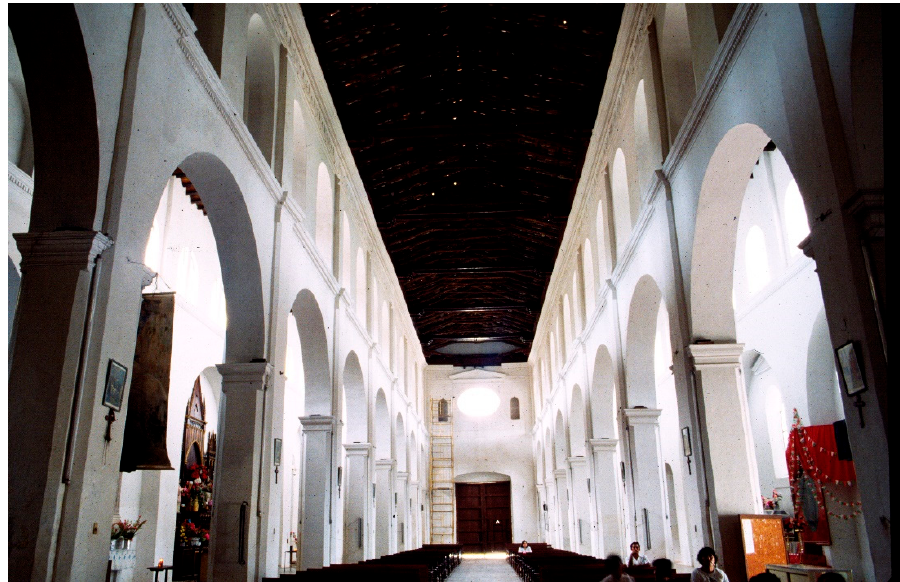
Figure 5. Interior of Santo Domingo church. Chiapa del Corzo. Photo took by author.